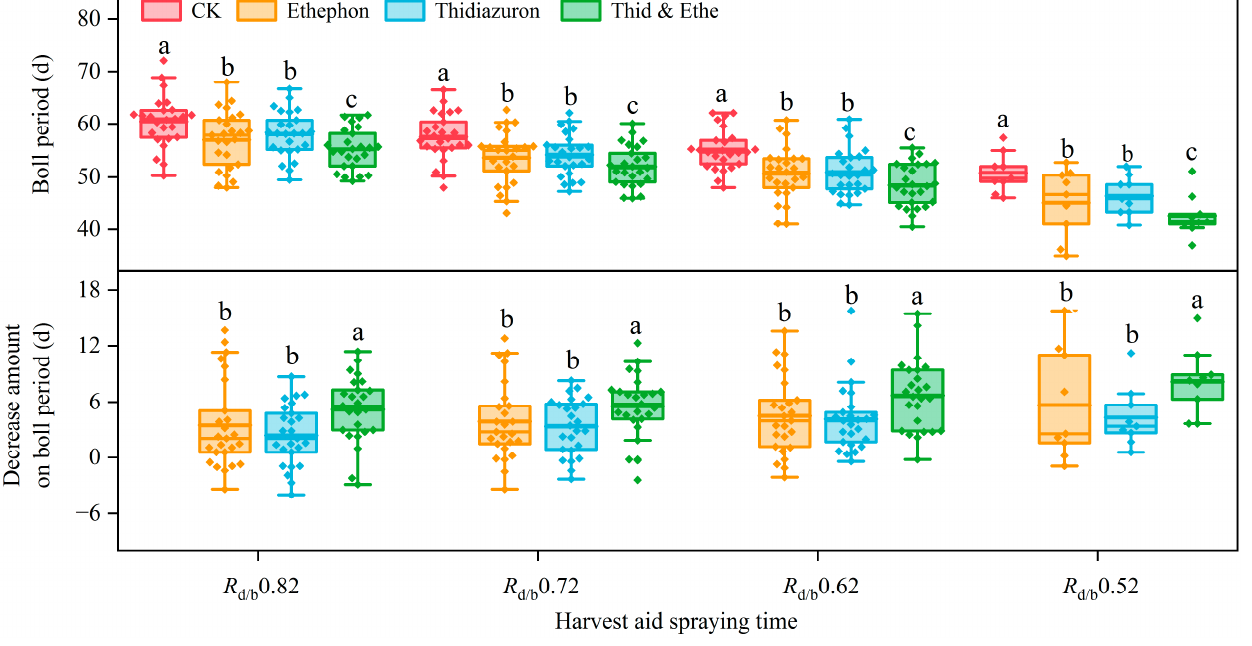
Figure 2. Effects of harvest aid spraying time on the cotton boll period. The thick solid line in the figure indicates the average value. The different letters indicate significant differences between harvest aid treatments at the same spraying time ( p < 0.05). When the spraying time was R d/b 0.52, the number of samples was 9, and the number of other samples was 25.